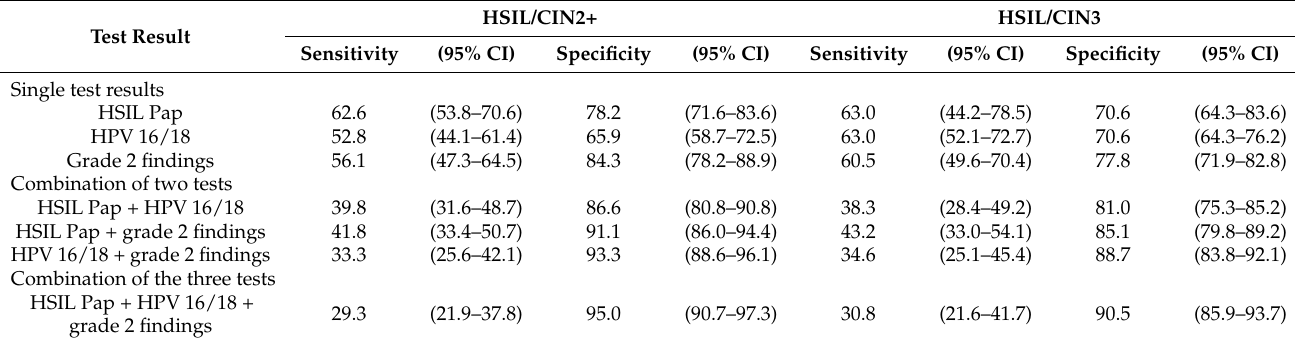
Table 5. Sensitivity and specificity of the HSIL cytology, HPV 16 and or 18 infection, abnormal findings grade 2 at the colposcopic impression and combination of the three results for the diagnosis of HSIL/CIN2+ and HSIL/CIN3. Test